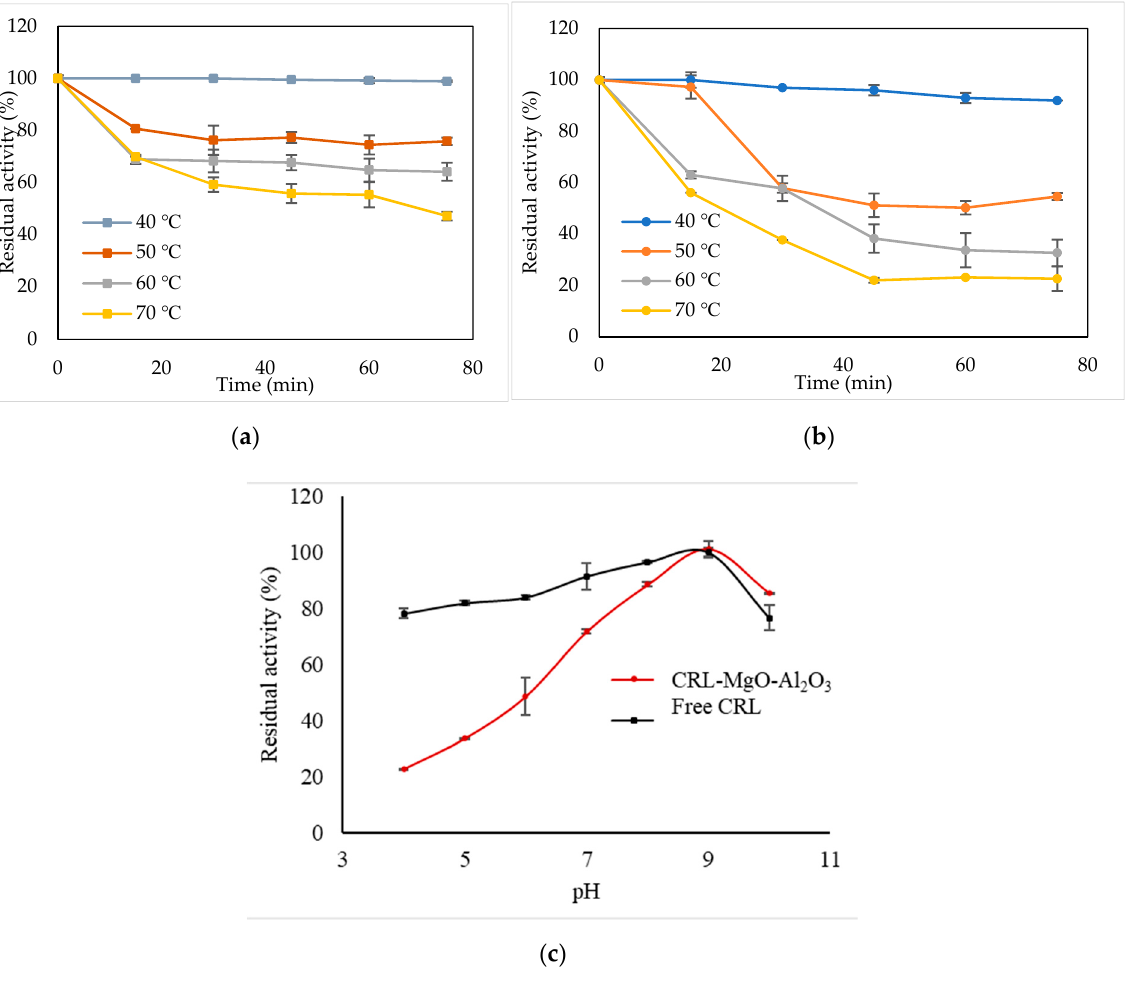
Figure 5. Thermal stability of ( a ) free CRL and ( b ) CRL/MgO-Al 2 O 3 at 40, 50, 60, and 70 °C while ( c ) pH stability for free CRL and CRL/MgO-Al 2 O 3 . The initial activity of free CRL and CRL/MgO-Al 2 O 3 before being incubated at varying ranges of temperature and pH was set as 100%. The error bars show standard deviations; all studies were conducted in triplicate.